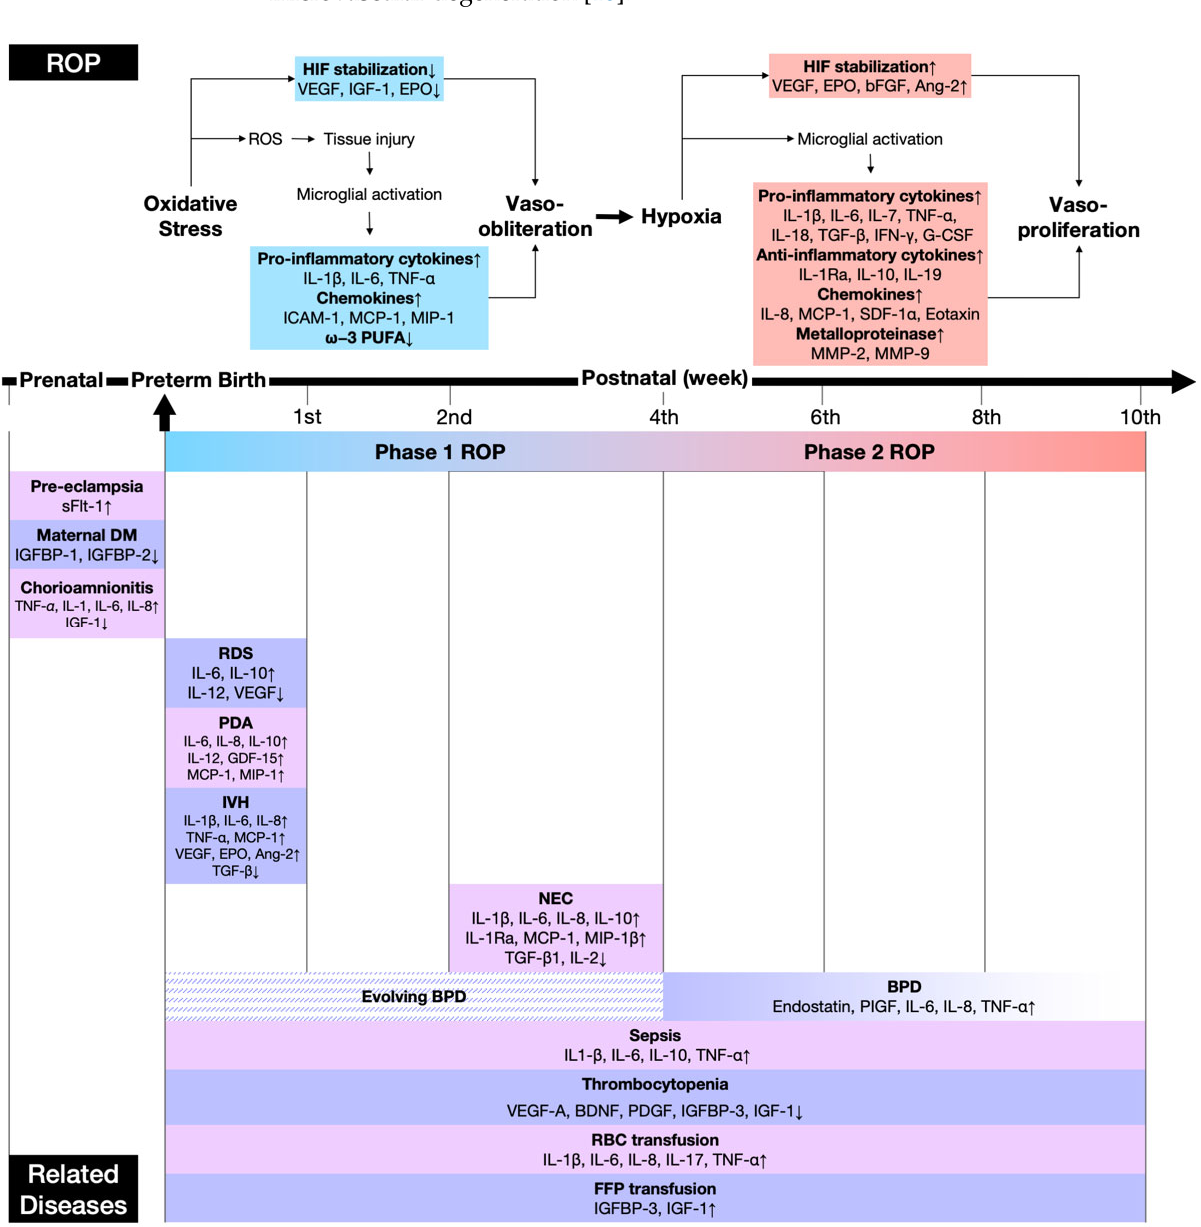
Figure 1. Common inflammatory and angiogenic mediators involved in the pathogenesis of retinopathy of prematurity (ROP) and the associated maternal and neonatal conditions. During phase I, oxidative stress suppresses pro-angiogenic factors. Hyperoxia-induced damage triggers over-activated inflammation, resulting in vaso-obliteration. During phase II, the hypoxic environment upregulates pro-angiogenic factors by hypoxia-inducible factor (HIF) and promotes both pro-inflammatory and anti-inflammatory cytokines. Anti-inflammatory cytokines may also display some pro-inflammatory properties. The subsequently upregulated metalloproteinase degrades the extracellu- lar matrix, stimulates endothelial cell migration, and further recruits more growth factors, eventu- ally causing vasoproliferation extending from the retina into the vitreous. The common onset timing of several maternal and neonatal conditions associated with the alternation of systemic cytokines is described below. These factors may contribute to ROP pathogenesis. Sepsis, thrombocytopenia, and blood transfusions are illustrated throughout the timeline since they can occur at any time. ↑ : up- regulation; ↓ : downregulation. Abbreviations: ROP: retinopathy of prematurity; ROS: reactive oxy-